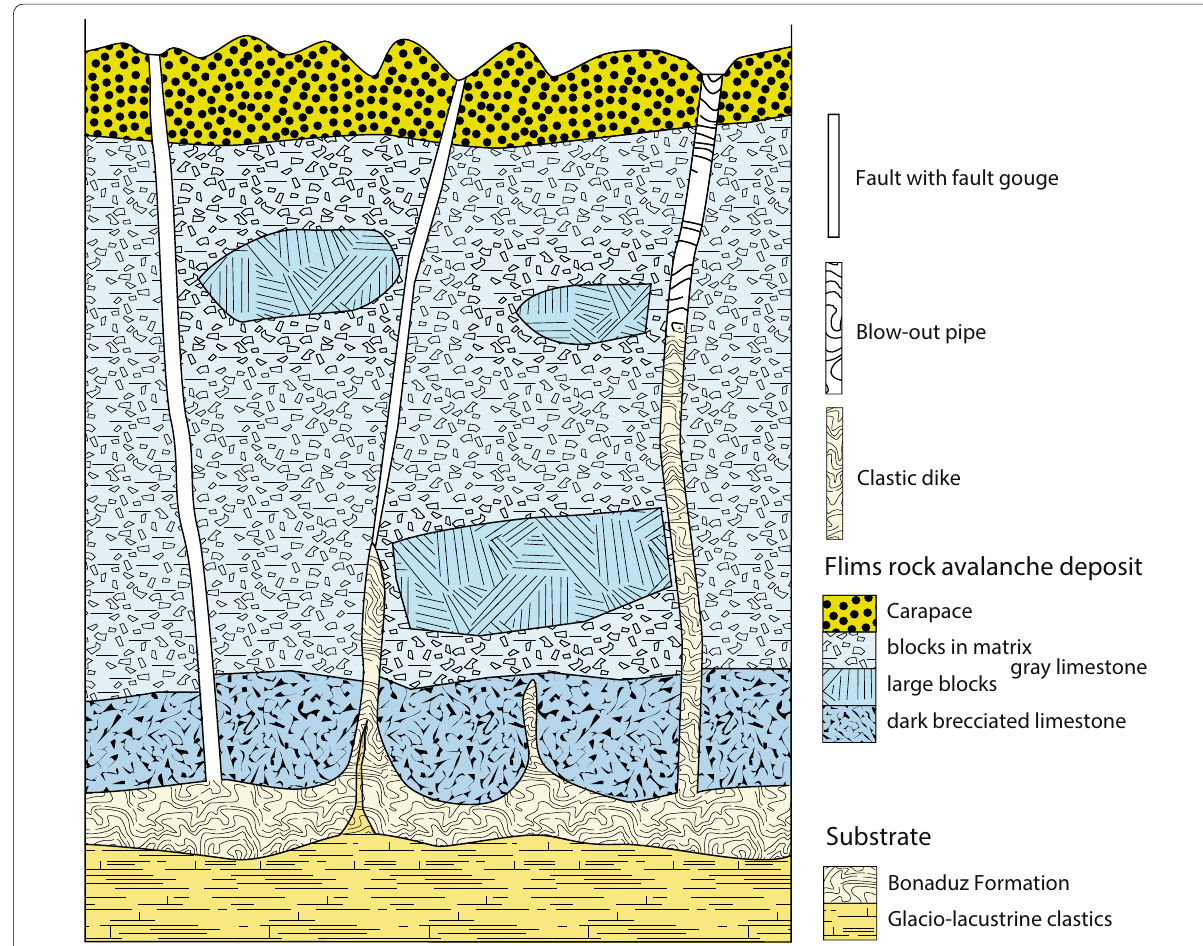
Fig. 25 Synoptic cross-section through the Flims rock avalanche showing the geometric relationships between the various rock types, faulting and injection. Not to